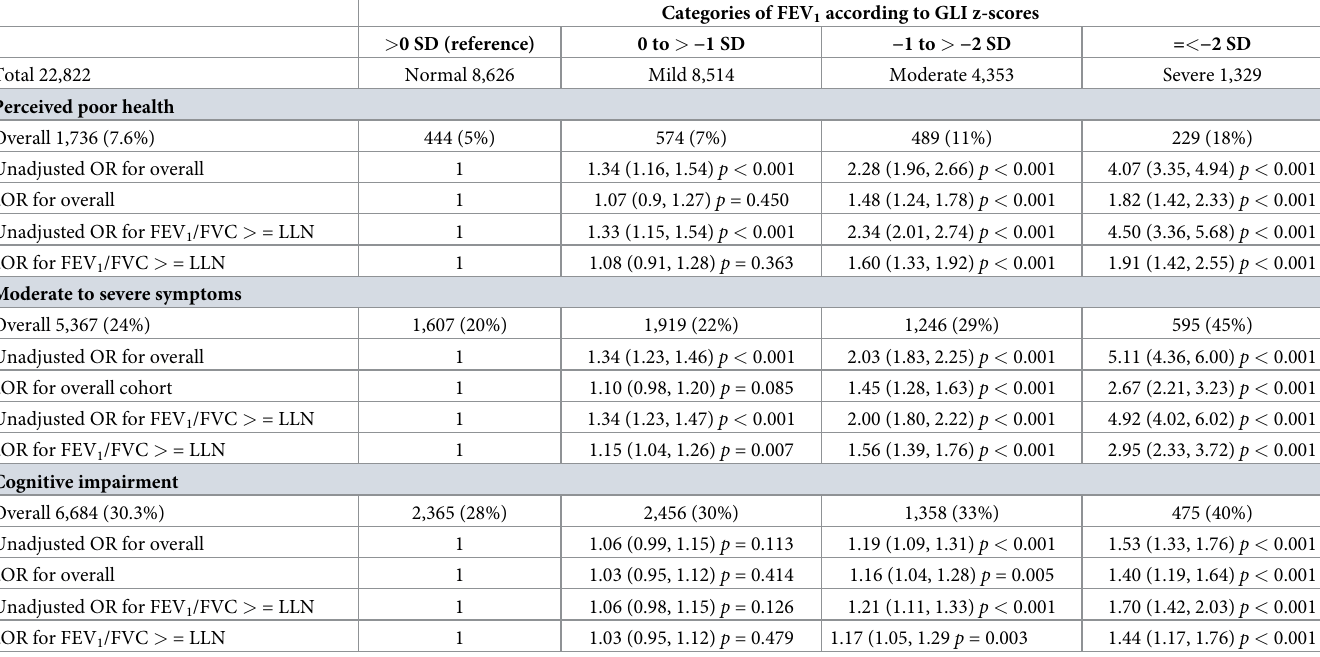
Table 2. Self-reported perceived poor health, respiratory symptoms, and cognitive impairment for different grades of low FEV 1 compared to reference (FEV 1 > 0 SD) in the overall cohort and in a subgroup without spirometry AO (shown here as FEV 1 /FVC > = LLN). Categories of FEV 1 according to GLI z-scores > 0 SD (reference) 0 to > − 1